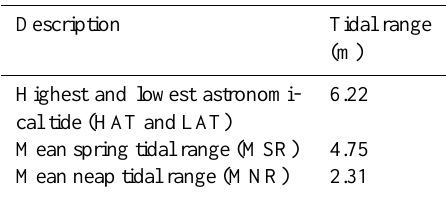
Figure 2. (a) Observed sea levels (with the 30 day running mean and the linear trend displayed), and shown in red the 1 in 1-year threshold offset for linear SLR; (b) astronomical tide; (c) non-tidal residuals (red line) and skew surges (black dots). 3 Table 1a. Tidal range at Newlyn. Astronomical tidal levels are those computed for the period 2008 to 2026, available from the National Tide and Sea Level Facility (www.ntslf.org).